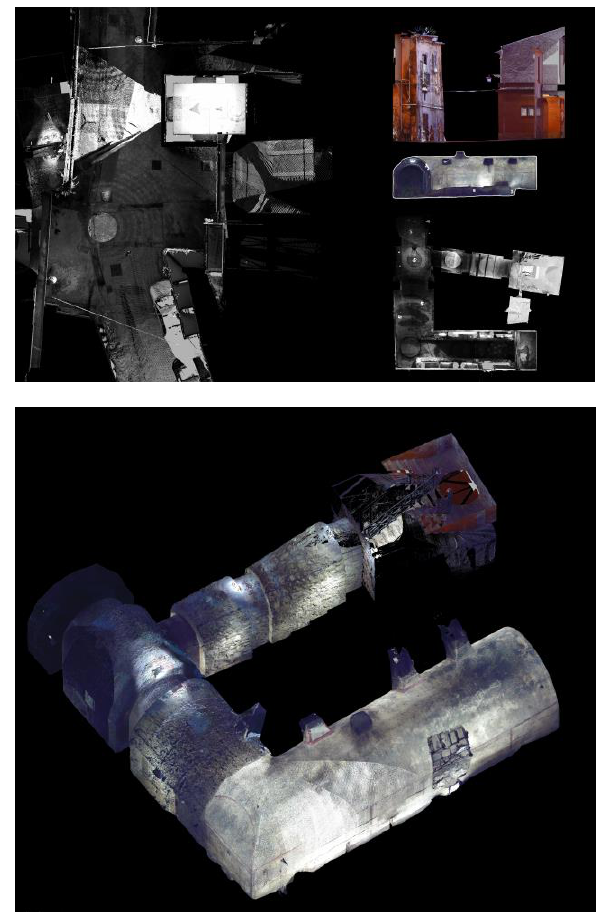
Figure 2 - 3. Views of the digital model of the point cloud